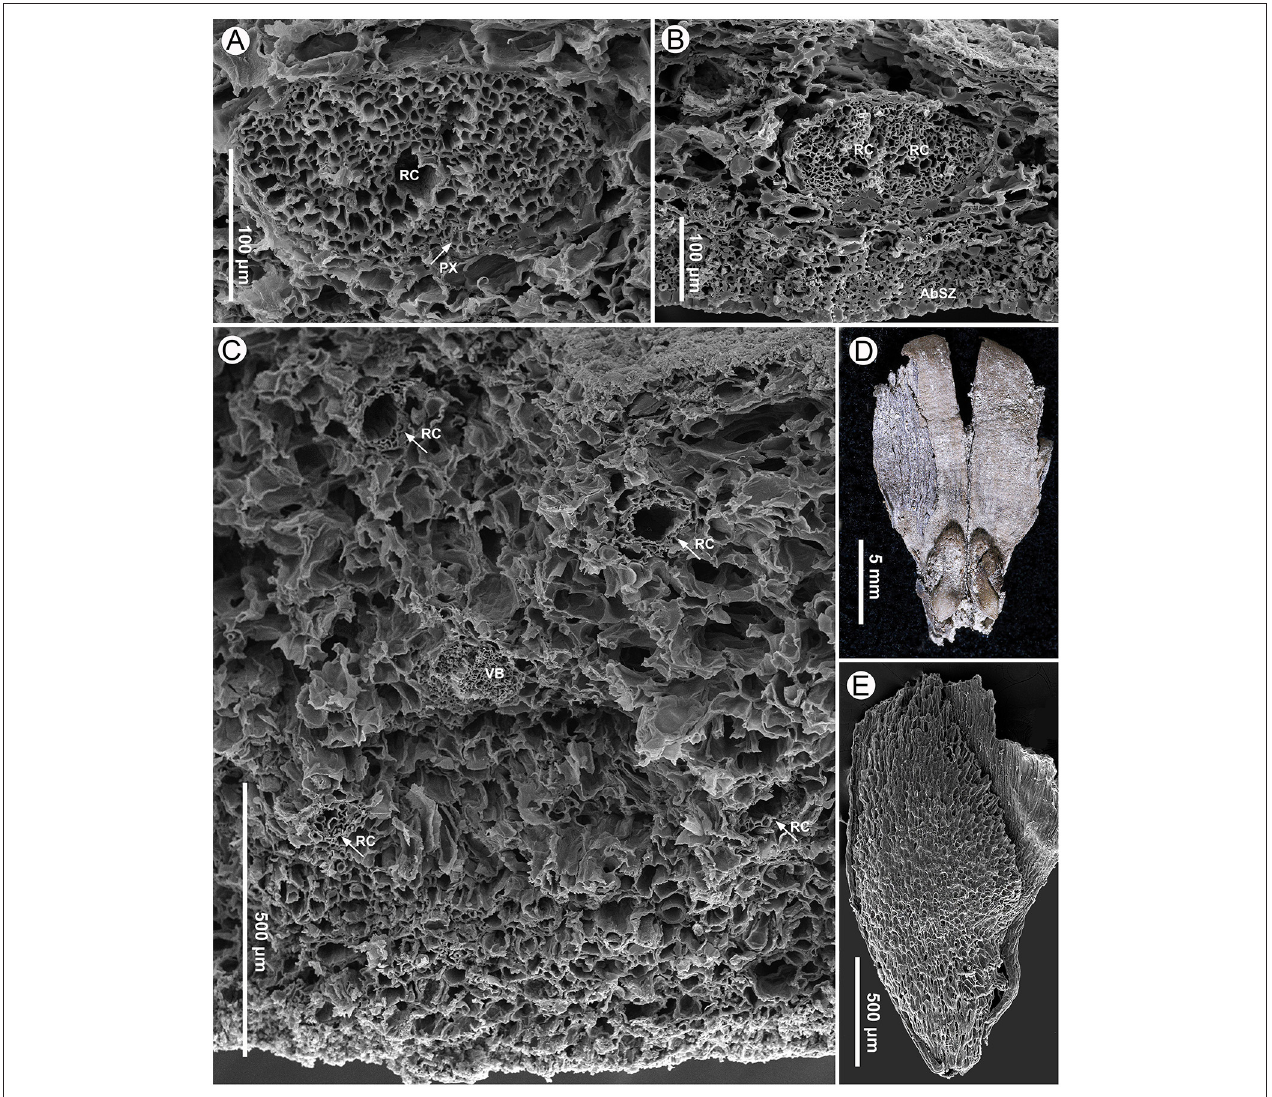
FIGURE 7 | Seed scale anatomy (specimen MMRH171) and seeds (specimen MMRH188) of Pinus prehwangshanensis sp. nov. (A) A vascular bundle of a seed scale with a resin canal (RC) and well-preserved protoxylem (PX, indicated by arrow), SEM. (B) A bifurcating vascular bundle with two resin canals (RC); note a sclerified zone (AbSZ) in the abaxial cortex, SEM. (C) Abaxial and adaxial resin canals (RC, indicated by arrows) in the distal dilated part of a seed scale near the apophysis base and their arrangement relative to a vascular bundle (VB), SEM. (D) A fragment of seed scale with two winged seeds. (E) A seed showing cells of the sclerotesta, SEM. ( Figures 6A,B ). The adaxial cortex sclerified zone is up to 45 µ m thick ( Figures 5B , 6A